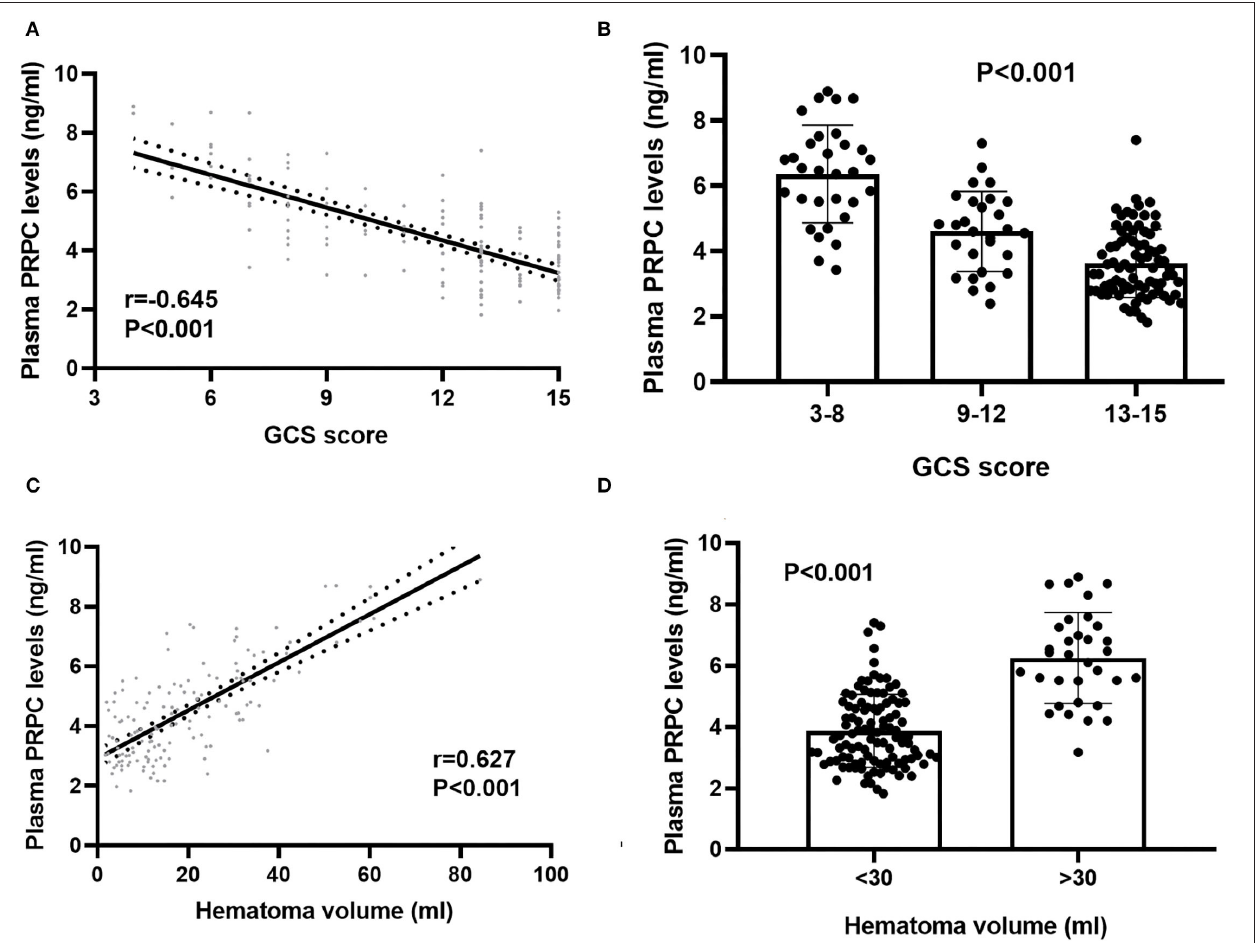
FIGURE 3 | Relationship between plasma cellular prion protein levels and illness severity among intracerebral hemorrhage patients. (A) Correlation of plasma cellular prion protein levels with Glasgow Coma Scale score. Plasma cellular prion protein levels were significantly raised with decreasing Glasgow Coma Scale score using Spearman correlation coefficients ( r = − 0.645, P < 0.001). In a correlation graph, the solid line means the line of best fit, and the dashed line represents 95% confidence interval of a population mean. (B) Differences in plasma cellular prion protein levels among patients with different Glasgow Coma Scale scores. Glasgow Coma Scale score was identified as a categorical variable and subsequently, patients were divided into three groups in accordance with the Glasgow Coma Scale score, namely, 3–8 ( n = 31), 9–12 ( n = 28), and 13–15 ( n = 79) and subsequently, patients with Glasgow Coma Scale score 3–8 had substantially highest plasma cellular prion protein levels, followed by Glasgow Coma Scale score 9–12 and then 13–15 using Kruskal–Wallis H-test ( P < 0.001). (C) Correlation of plasma cellular prion protein levels with hematoma volume . Plasma cellular prion protein levels were substantially elevated with rising hematoma volume using Spearman correlation coefficients ( r = 0.627, P < 0.001). In a correlation graph, the solid line means the line of best fit, and the dashed line represents 95% confidence interval of a population mean. (D) Differences in plasma cellular prion protein levels among patients with different hematoma volumes. Hematoma volume was identified as a categorical variable, patients with hematoma volume above 30ml ( n = 33) had substantially higher plasma cellular prion protein levels than those with hematoma volume below 30ml ( n = 105) using Mann–Whitney U -test ( P < 0.001). Abbreviations: GCS, Glasgow Coma Scale; PRPC, cellular prion